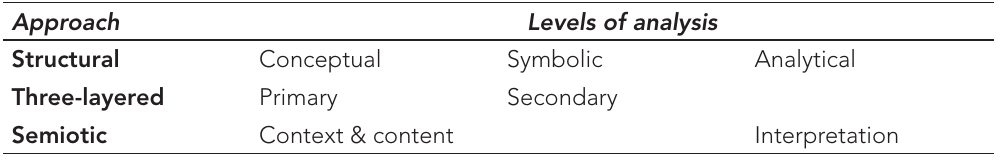
Table 2: My approach to image analysis